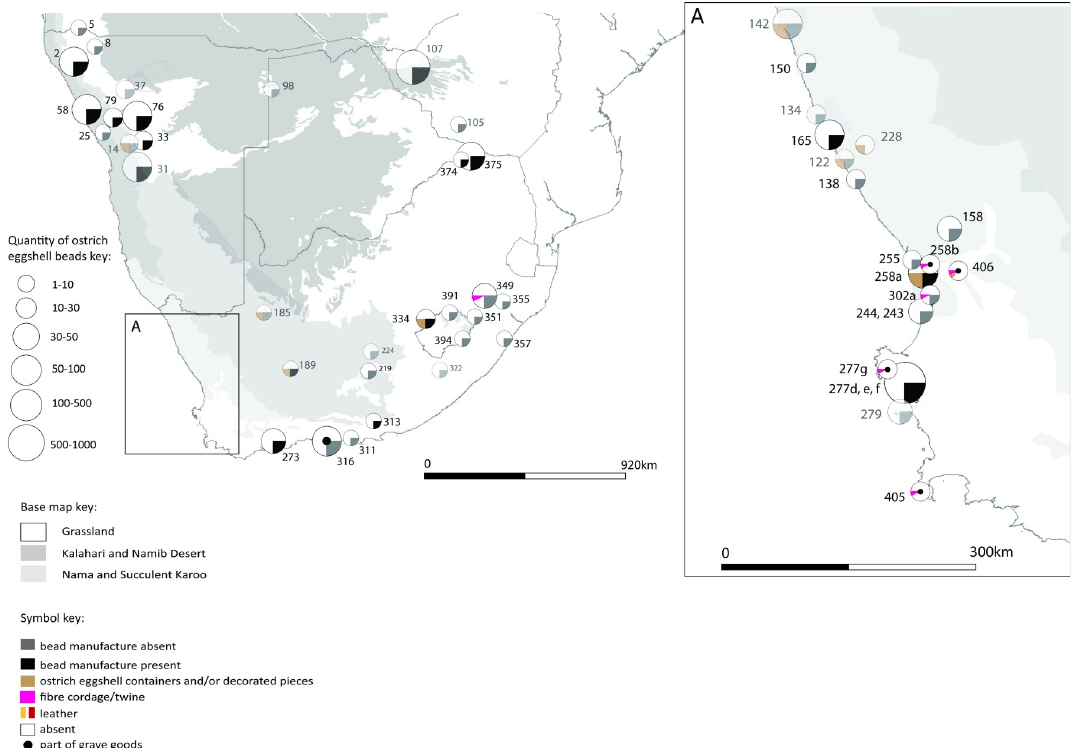
Fig 5. Map 1 showing the distribution of organic finds in the period 891–291 cal